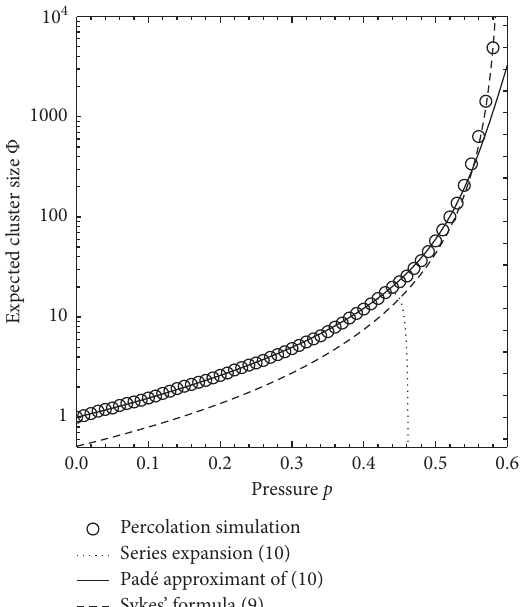
Figure 1: Simulated mean cluster size and expected cluster sizes based on Sykes’ formula (9), their low-density series expansion ap- proximation (10) of Φ , and the [46/1] Pad´e approximant of (10).